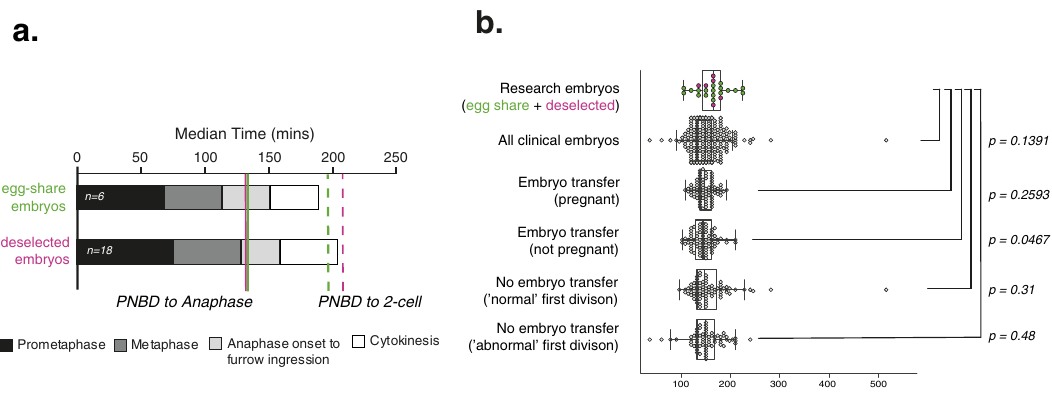
Fig. 4 | Deselected embryos have similar mitotic timing to clinical embryos. a Median durations of each mitotic phase plotted consecutively from 6 complete egg-share embryos movies and 18 deselected embryo movies during the fi rst mitosis. b Quanti fi cation of timing from PNBD or pronuclear fading to furrow ingression (start of cytokinesis) for complete movies of research embryos (dese- lected (pink) and egg-share (green), n =24) and clinical embryos (imaged using EmbryoScope during patient treatment, grey background, n =304). Box and whisker plots represent minimum, lower quartile, median, upper quartile and maximum. Outliers fall beyond these lines. Individual data points are overlaid. Clinical embryos fall into four categories: singly transferred embryos which gave